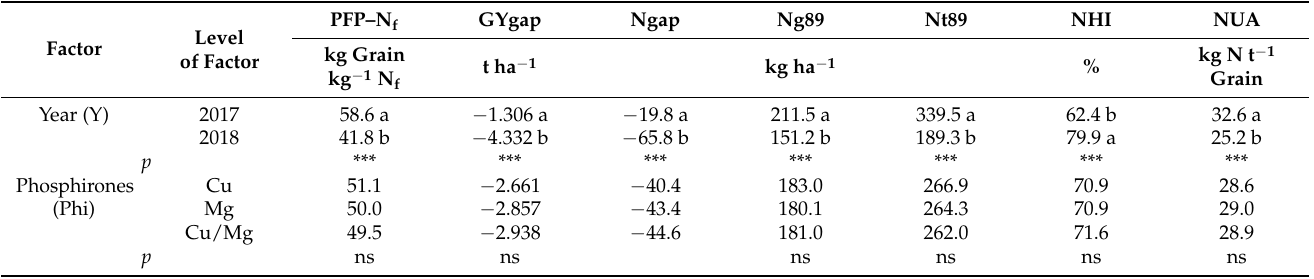
for plots protected with a predominance of fungicides. In 2018, this trend was also observed, but differences between treatments were less pronounced. Table 5. Characteristics and indices of nitrogen economy of winter wheat at